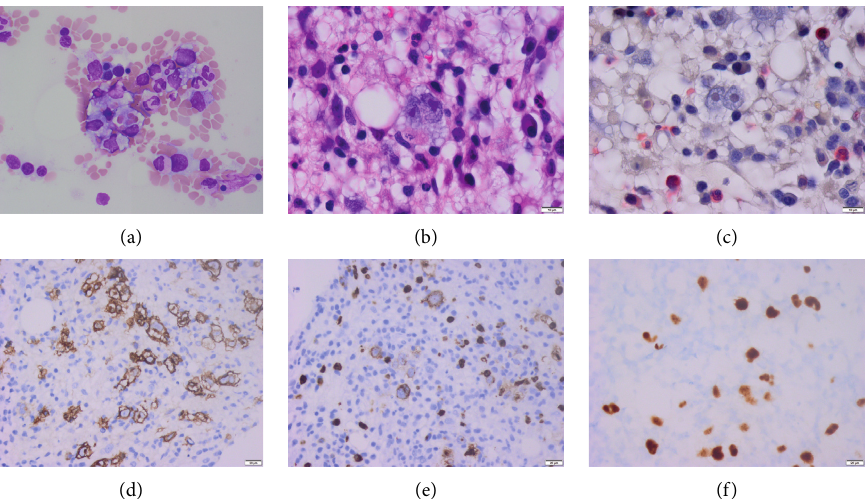
Figure 3: H&E section of the bone marrow revealing hemophagocytosis (a). High-powered H&E section (b) and chloracetate esterase section (c) demonstrating binucleated Reed–Sternberg (RS) cells. Immunohistochemistry showed positivity for CD30 (d) and CD15 (e) in RS cells. Epstein–Barr encoding region in situ hybridization (EBER-ISH)